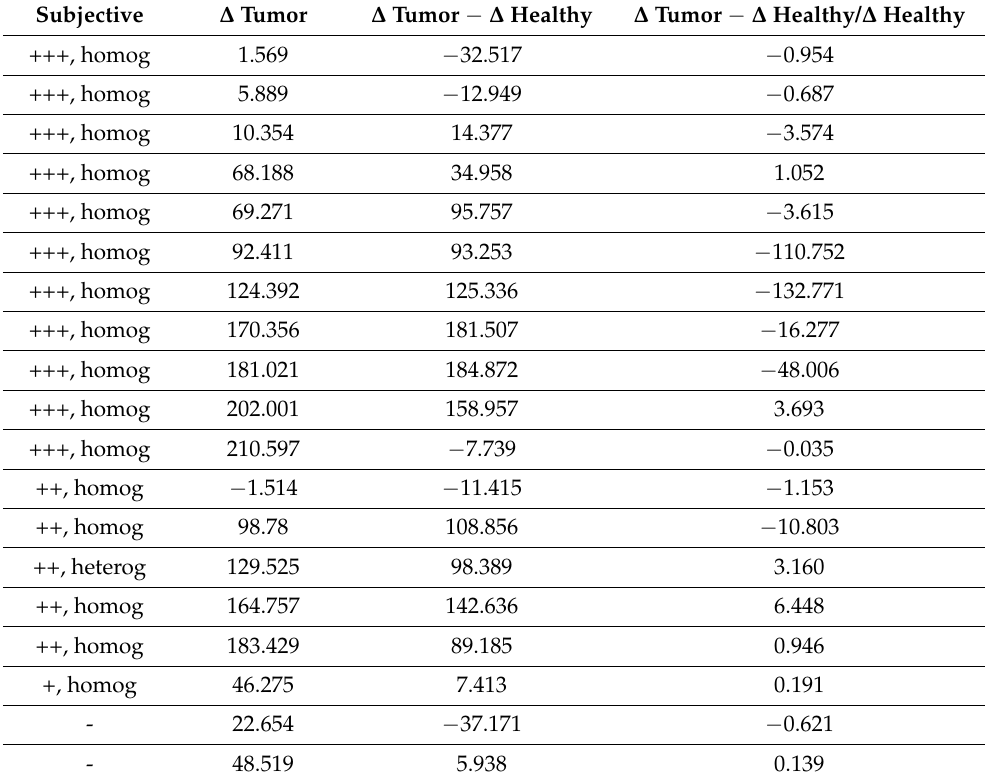
Table 1. Comparison of subjective fluorescence perception to numerical differences in green intensity. Subjective ∆ Tumor ∆ Tumor − ∆ Healthy ∆ Tumor − ∆ Healthy/ ∆ Healthy +++, homog